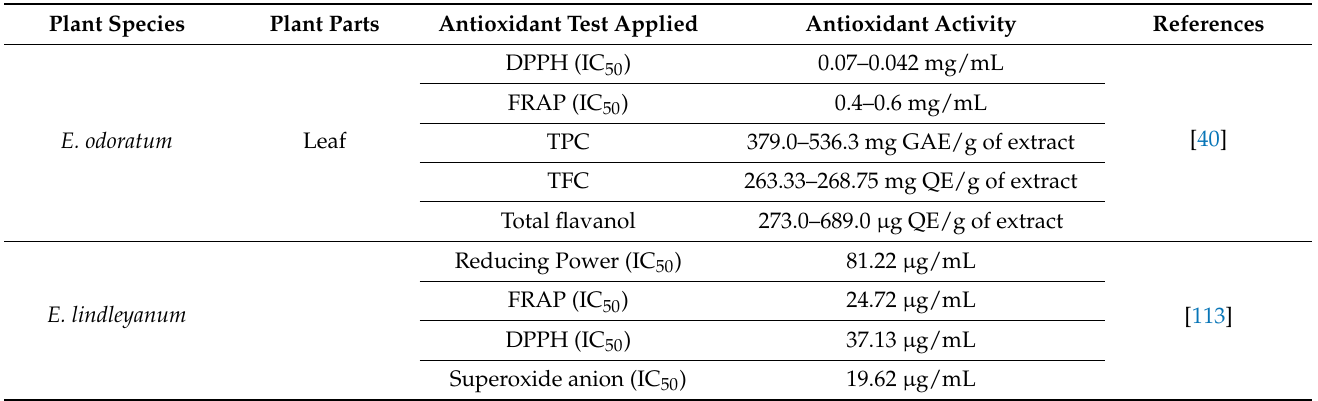
Table 2. The potency of the radical scavenging activity from Eupatorium species (total phenolic content (TPC) anb total flavonoid content